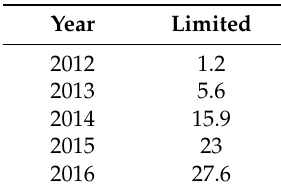
Table 2. The share of Syrian partnership